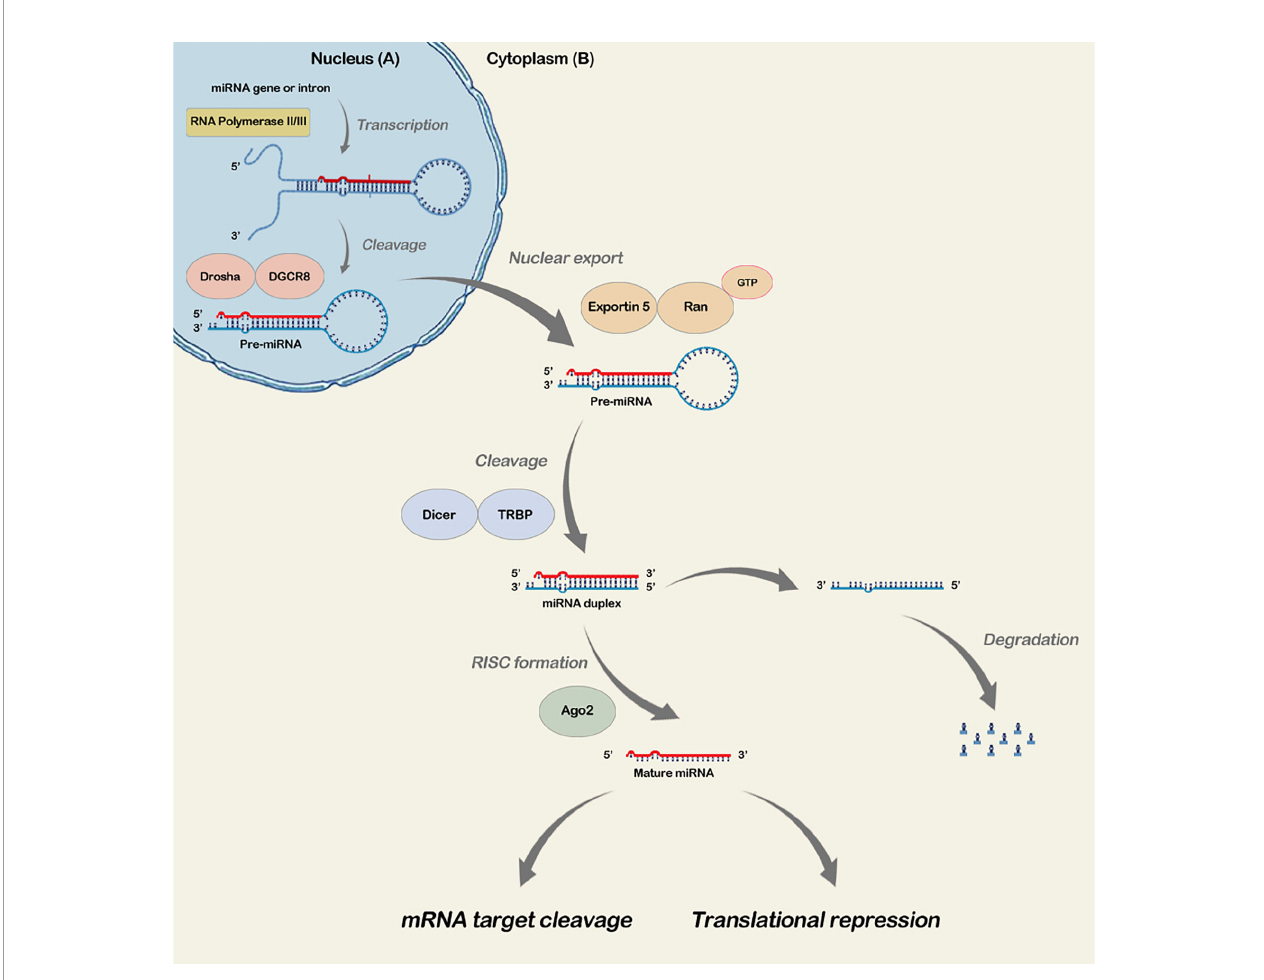
FIGURE 1 | microRNA Biogenesis Steps. In the nucleus, miRNA gene transcription occurs by RNA polymerase III, resulting in the primary double-stranded miRNA (pri73 miRNA). The miRNA precursor (pre-miRNA) formation occurs, which is transported to the cytoplasm through exp5 and the Ran GTP cofactor (A) . In the cytoplasm, pre miRNA is processed by Dicer RNAse, resulting in a double-stranded RNA, mature RNA and microRNA-5p. The second is degraded, and the mature microRNA binds to Argonaut protein (AGO) and forms the RNA-induced silencer complex (RISC). Mature microRNAs incorporate into RISC, regulating gene expression by mRNA degradation or transductional repression (B)